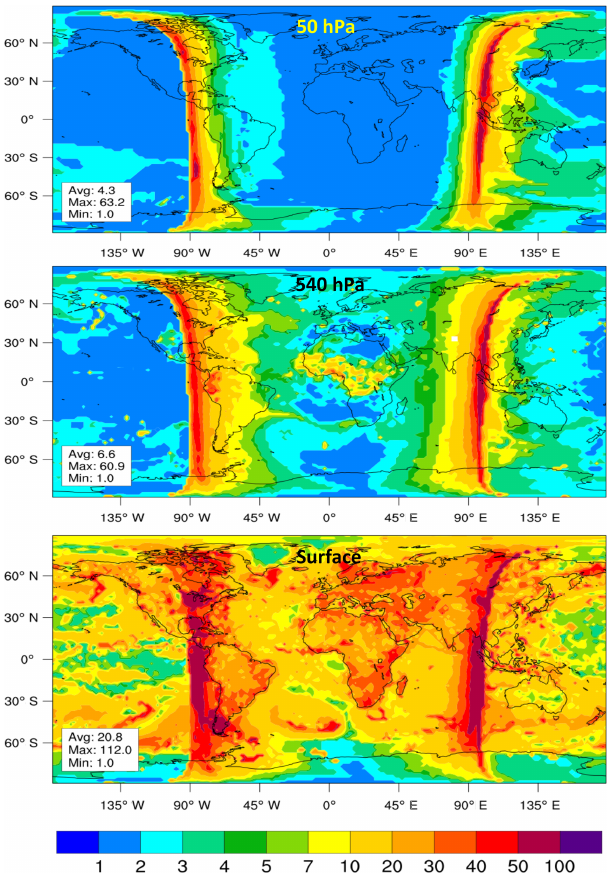
Figure 5. Number of sub-time-steps per time step of 15min in the MA simulation for the 15 September at midday. Three levels are presented representative of the stratosphere (50hPa), the midtropo- sphere (540hPa), and the